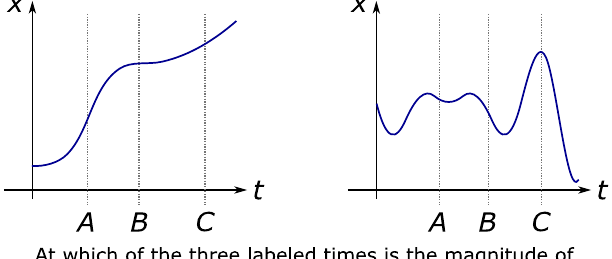
FIG. 5. Screening questions used to gauge ability to determine the magnitude of velocity from a position vs time graph. Both graphs were presented to the student along with the prompt